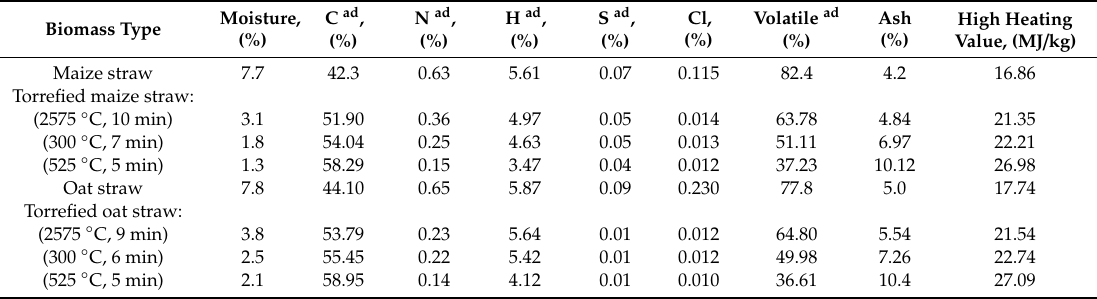
Table 3. Elemental analysis and technical analysis of maize and oat straws before and after torrefaction